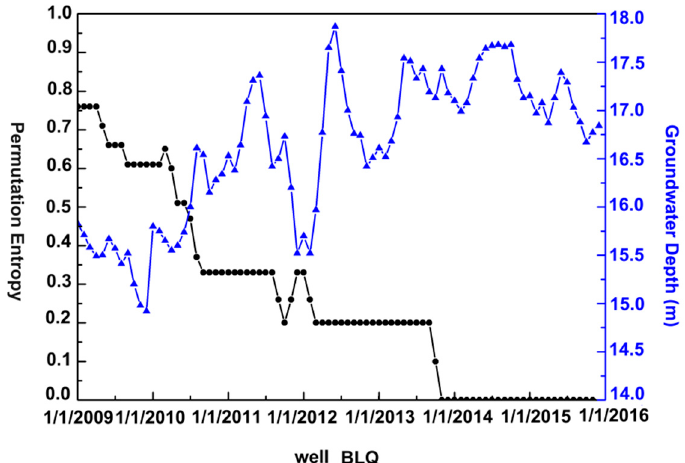
Figure 11. Comparison of the PE results for well BLQ and the variations in the groundwater level. The blue line indicates the groundwater level variations. The black line represents the PE results. The groundwater data reference datum is the same as that in Figure 10.